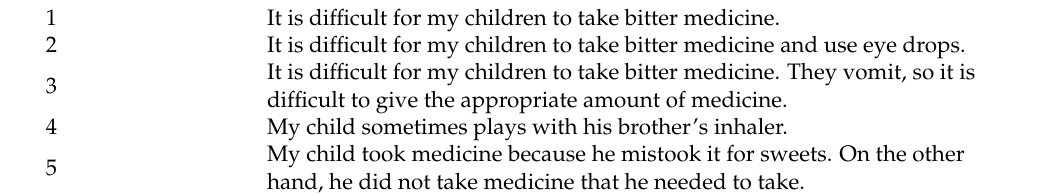
Figure 5. Questionnaire results for the parents of children and free comments. Table 6. Free comments about children.